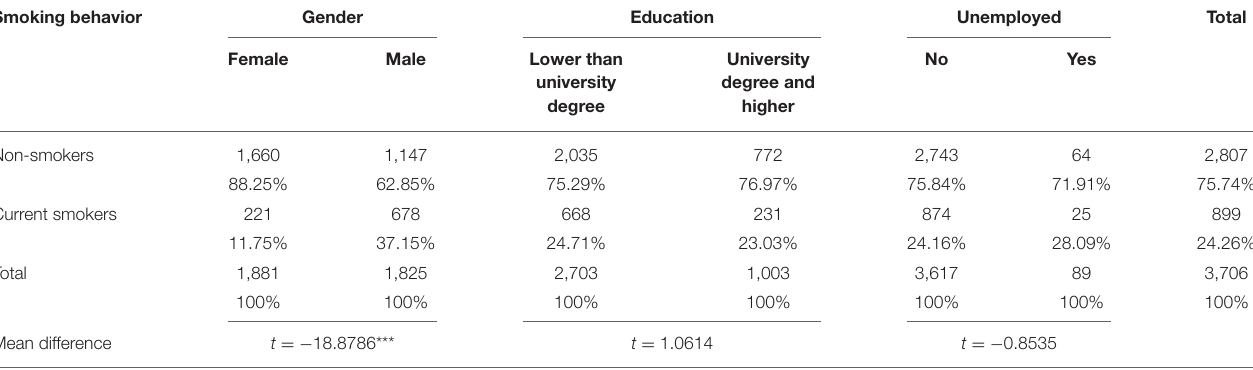
TABLE 4 | Distribution of smoking behavior by demographic characteristic.